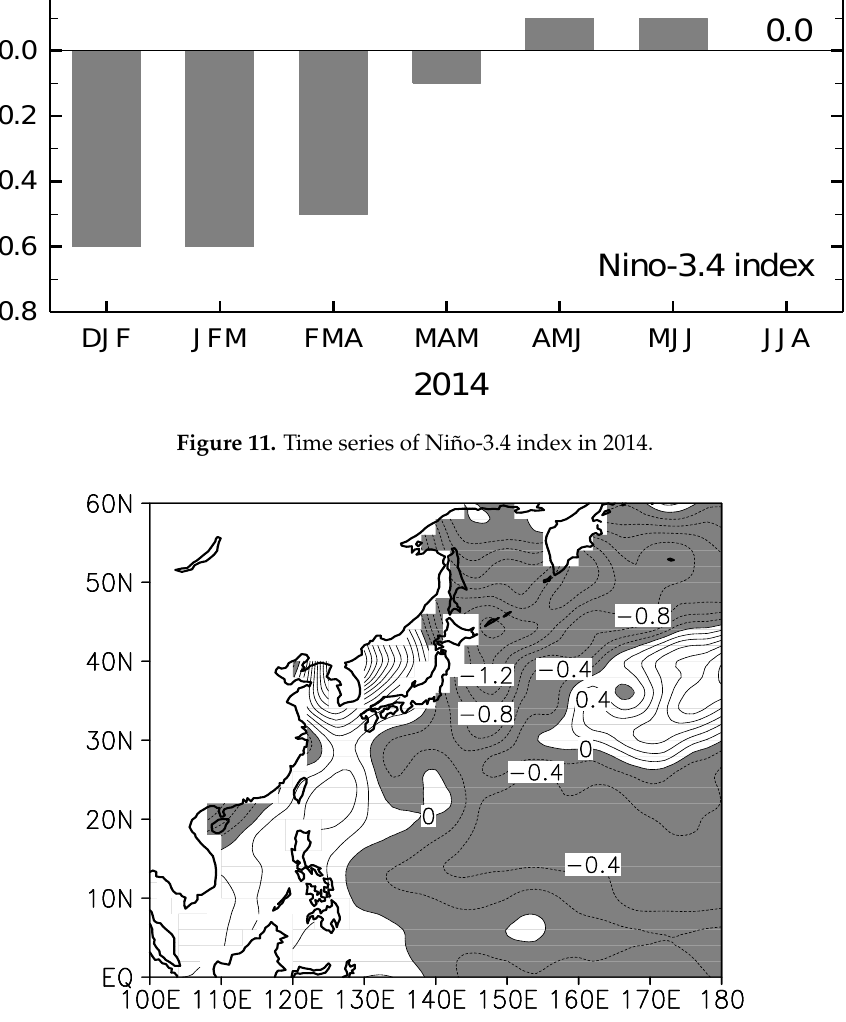
Figure 12. Same as in Figure 4, but for sea surface temperature (SST). Contour interval is 0.2 °C. Shaded areas denote negative values.